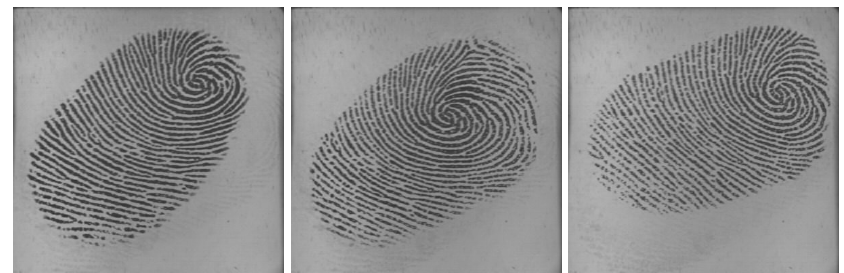
Figure 2. Three impressions from the same